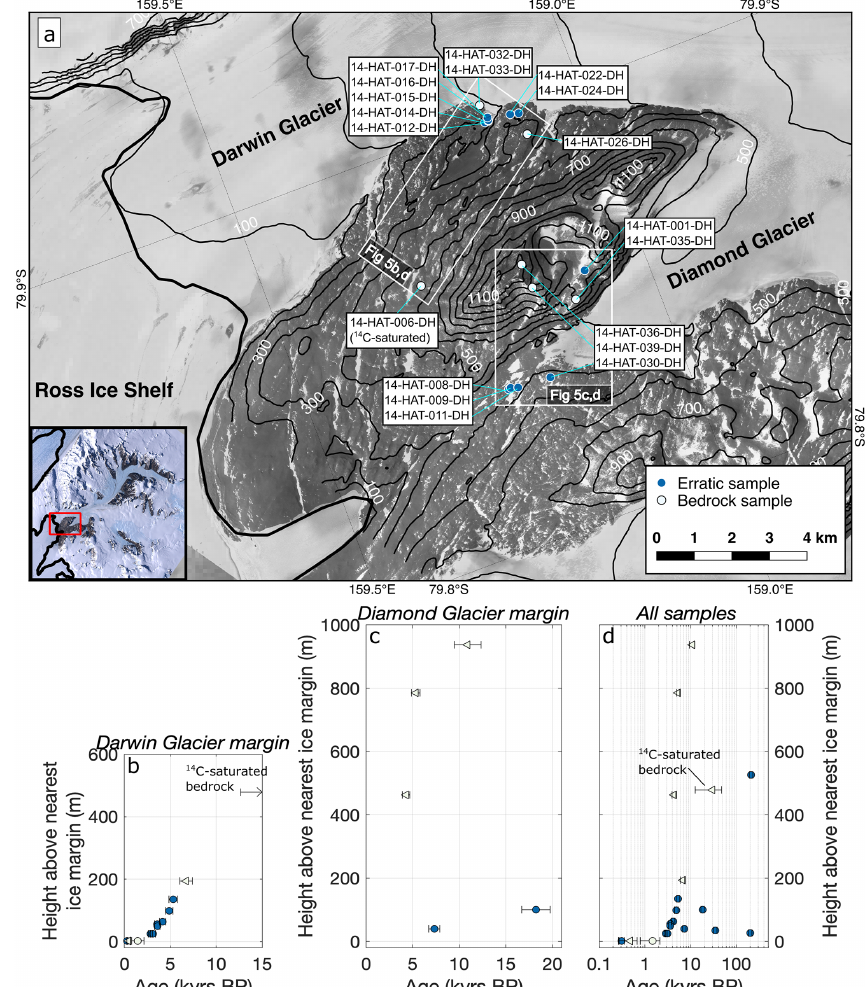
Figure 5. (a) Map of Diamond Hill with bedrock and erratic sample locations. The modern grounding line is shown as a bold black line. Sample numbers are included because of the complexity of the topography and exposure age distribution relative to the sample locations in previous figures. Contours and satellite imagery from LINZ (2010), sourced from the NZTopo Database, Crown Copyright Reserved. This product (LINZ Darwin Glacier orthophotos) incorporates data which are © Japan Aerospace Exploration Agency (“JAXA”) 2008. Inset imagery from Bindschadler et al. (2008). Missing elevation contours in the lower left corner of the map reflect the edge of the LINZ DEM. White boxes indicate spatial distribution of samples in (b–d) . (b) Mean exposure ages with total uncertainty at 1 standard deviation from the side of Diamond Hill adjacent to Darwin Glacier. 14 C-saturated bedrock is represented as the lower 1-sigma uncertainty bound and an arrow pointing right in order to keep the recessional transect visible. Triangles and circles indicate bedrock and erratics, respectively. White and blue indicate 14 C and 10 Be, respectively. (c) Exposure ages from the Brown Hills and side of Diamond Hill (including summit samples) closer to Diamond Glacier. (d) All samples from the Diamond Hill–Brown Hills area on a logarithmic scale to show outliers and 14 C- saturated bedrock. Bedrock 14 C ages give a maximum time of last exposure, because inherited 14 C from exposure before the LGM cannot be quantified. The top of Diamond Hill, > 900m above the modern glacier surface, was covered during the LGM and was exposed sometime after 11ka. In contrast, the 14 C-saturated sample ∼ 500m above present-day Darwin Glacier suggests more modest LGM thickening relative to present. Therefore, it is not straightforward to interpret these data without a glacier flow model, and not all ages can conceivably represent the glacier